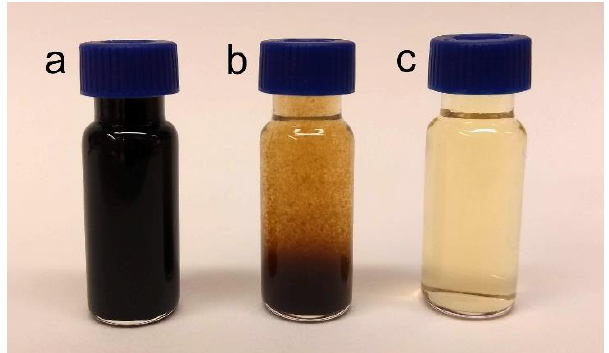
Figure 2. Hydrothermal liquefaction (HTL) product ( a ), acidified aqueous reaction product with precipitates ( b ), and filtrate of the acidified aqueous reaction products ( c ).